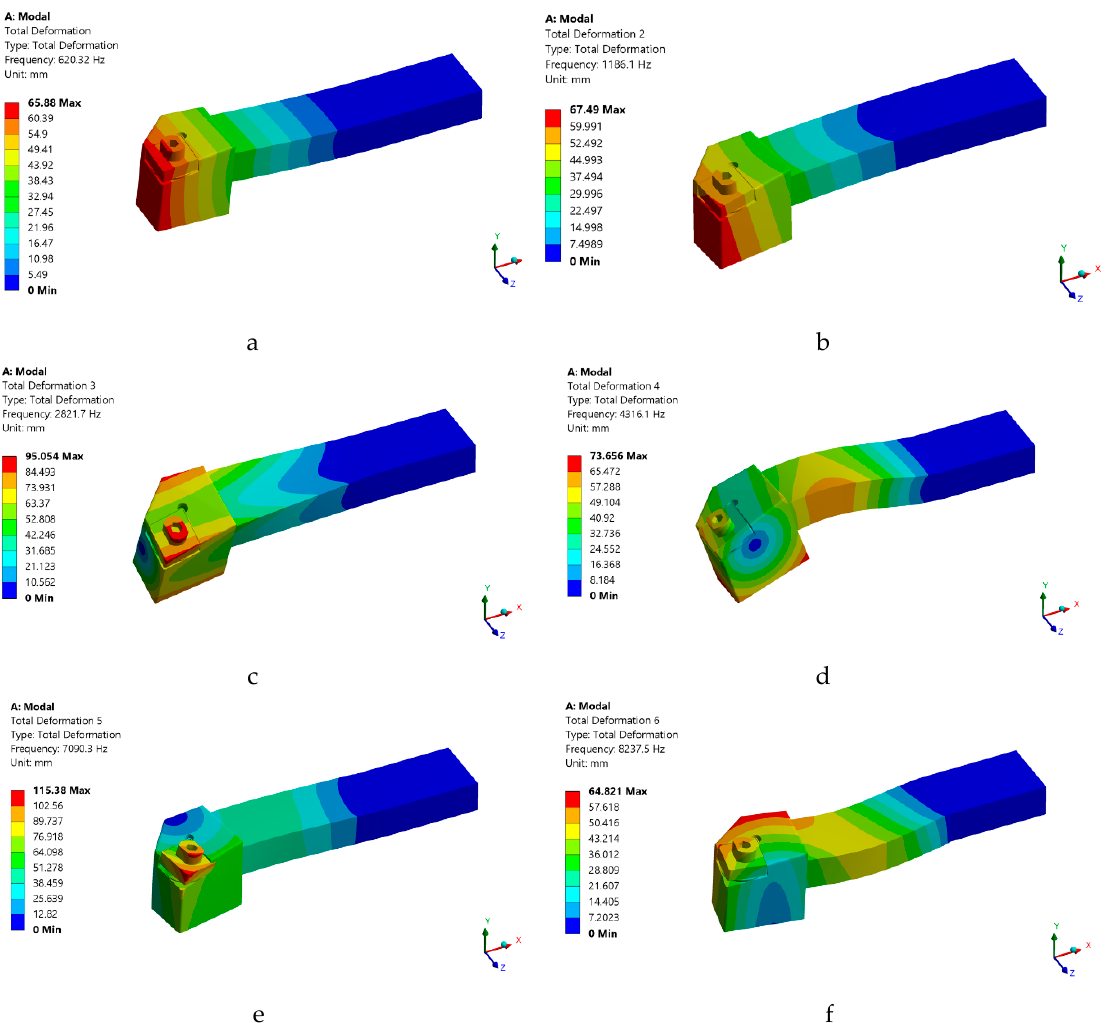
Figure 10. Own modes of vibration obtained by using FEM for the smart tool T02: ( a ) first own mode of vibration for a frequency of 620.3 Hz; ( b ) the second proper vibration mode for a frequency of 1186.1 Hz; ( c ) the third proper vibration mode for a frequency of 2821.7 Hz; ( d ) the fourth proper vibration mode for a frequency of 4316.1 Hz; ( e ) the fifth proper vibration mode for a frequency of 7090.3 Hz; ( f ) the sixth proper mode of vibration for a frequency of 8237.5 Hz.